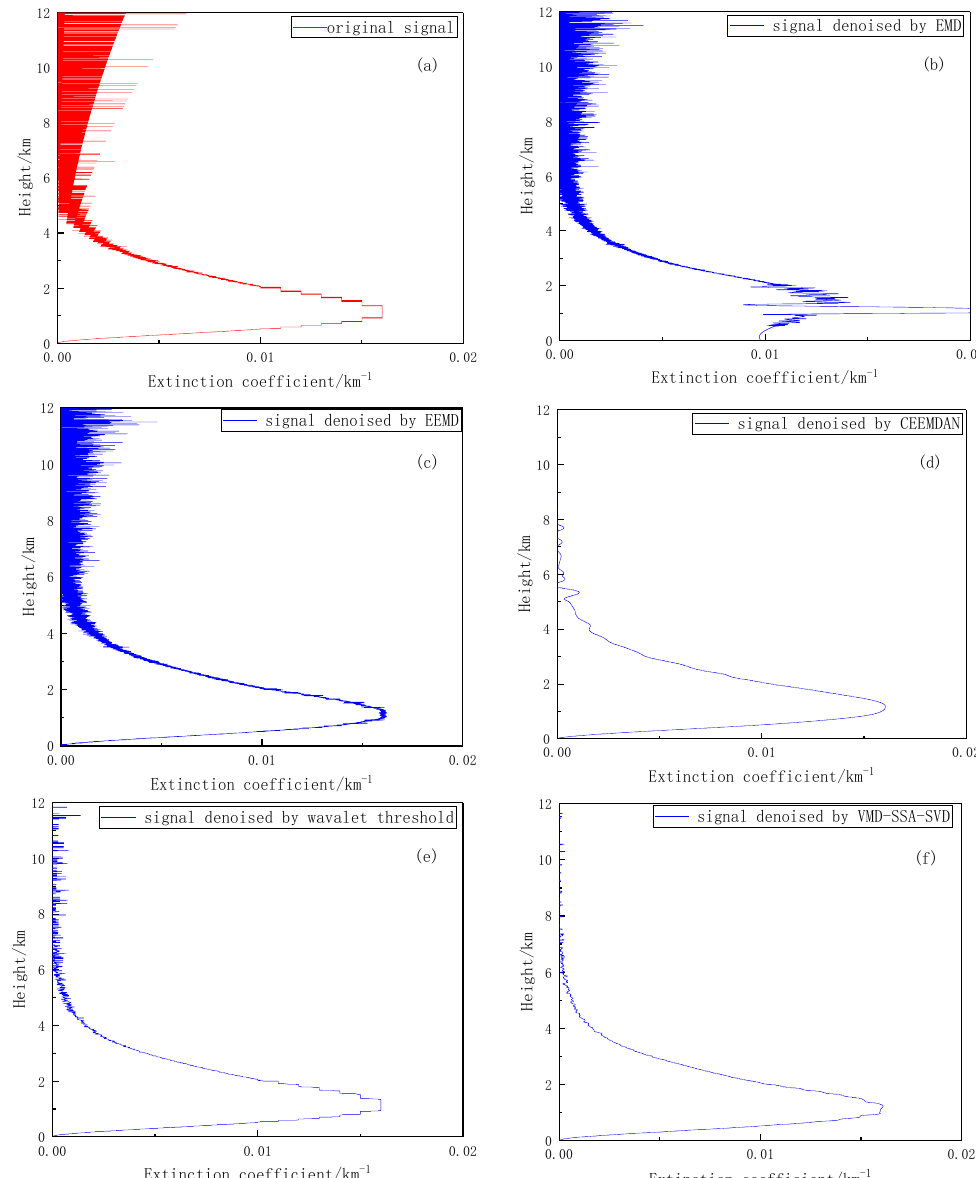
Figure 9. Denoised aerosol extinction coefficient profiles at 532-nm wavelength return signal inversion by different methods. ( a ) Original signal. ( b ) The signal processed by the EMD method. ( c ) The signal processed by the EEMD method. ( d ) The signal processed by the CEEMDAN method. ( e ) The signal processed by the wavelet threshold method. ( f ) The signal processed by the VMD-SSA-SVD method.